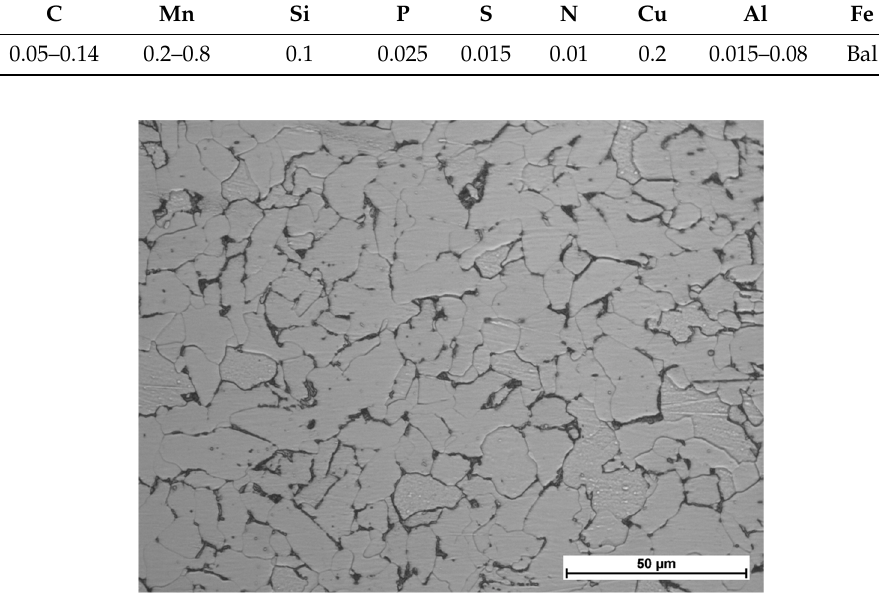
Figure 1. Microstructure of the substrate of non-alloy steel S235JR (Magnification 500×), Table 1.